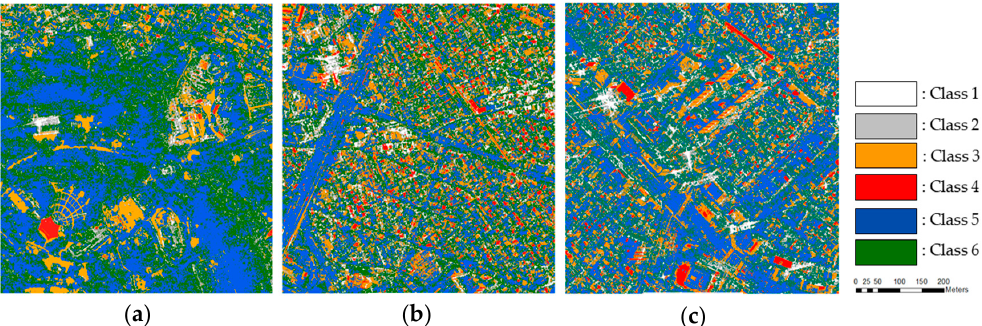
Figure 10. Classification images: ( a ) Site 1, ( b ) Site 2, ( c ) Site 3.